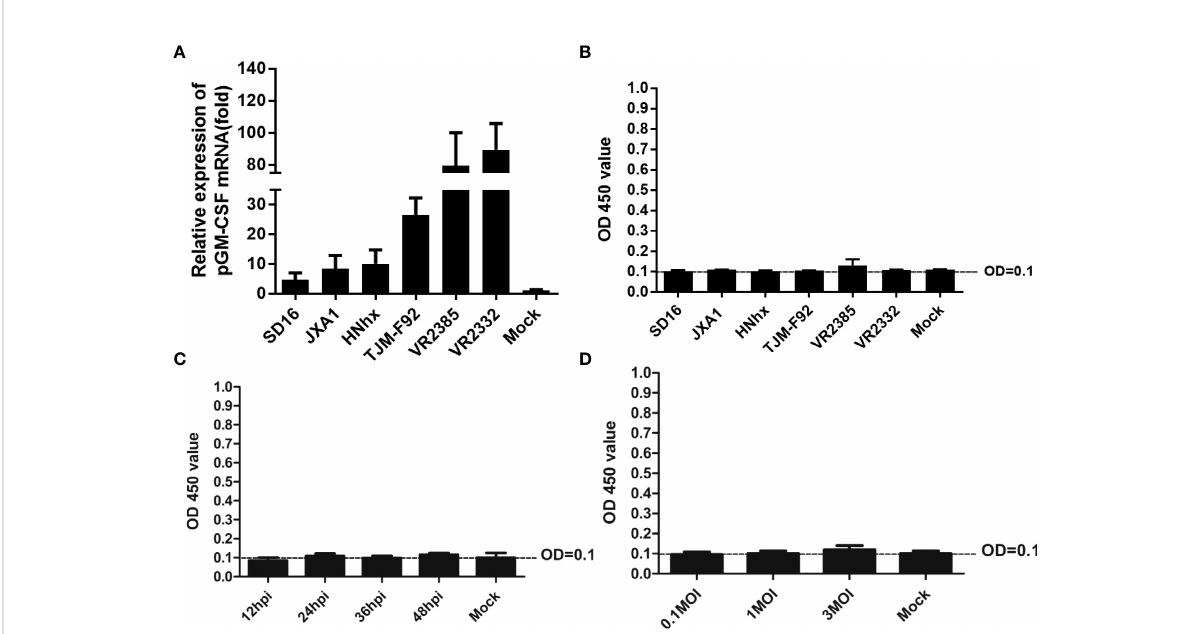
FIGURE 2 Evaluation of pGM-CSF mRNA and protein expression in PAMs infected by different PRRSV isolates. (A) PAMs were infected with heterogeneous PRRSV isolates (PRRSV-JXA1, SD16, NADC30-like strain HNhx, vaccine strain TJM-F92 and classic strains VR2385 and VR2332) at 1 MOI for 24 hours. Then the cells were harvested for qPCR to evaluate the mRNA level of pGM-CSF. Non-infected PAMs served as controls (MOCK). All experiment was repeated at least for three times. (B) Cell culture supernatant collected from PAMs infected with heterogeneous PRRSV isolates (PRRSV-JXA1, SD16, NADC30-like strain HNhx, vaccine strain TJM-F92 and classic strains VR2385 and VR2332) at 1 MOI for 24 hours were harvested for ELISA analysis for pGM-CSF proteins. Supernatant from non-infected PAMs served as controls (MOCK). (C) Cell culture supernatant collected from PAMs infected with PRRSV-JXA1 at 1 MOI for different time hours were harvested for ELISA analysis for pGM-CSF proteins. Supernatant from non-infected PAMs served as controls (MOCK). (D) Cell culture supernatant collected from PAMs infected with PRRSV-JXA1 at different MOIs were harvested for ELISA analysis for pGM-CSF proteins. Supernatant from non-infected PAMs served as controls (MOCK). All experiment was repeated at least for three times and all data are expressed as mean ±